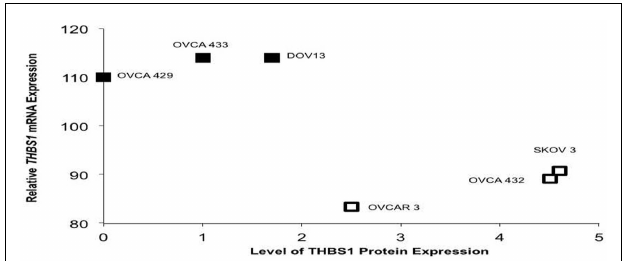
FIGURE 3 | TP53 mutation status in select ovariancancer cell lines and THBS1 mRNA and protein expression .The three ovarian cancer cell lines with wt TP53 demonstrated higher levels of THBS1 mRNA, but lower relative protein expression. Conversely, mutantTP53 cell lines had lower levels of THBS1 mRNA expression and higher levels of relative protein expression. TP53 missense mutation ; wt TP53 gene .